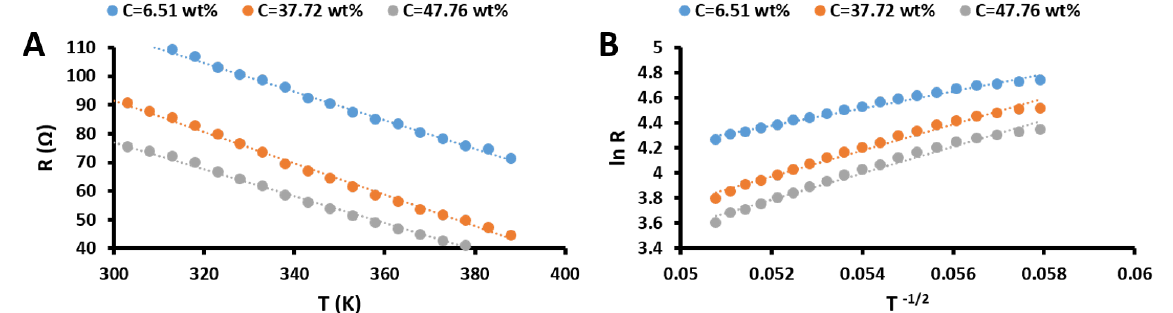
Figure 4. ( A ) Temperature-dependent resistances of the nanocomposite at different concentrations; ( B ) Analysis of resistance- temperature relationship of the nanocomposite treated cotton fabric with the VRH model.